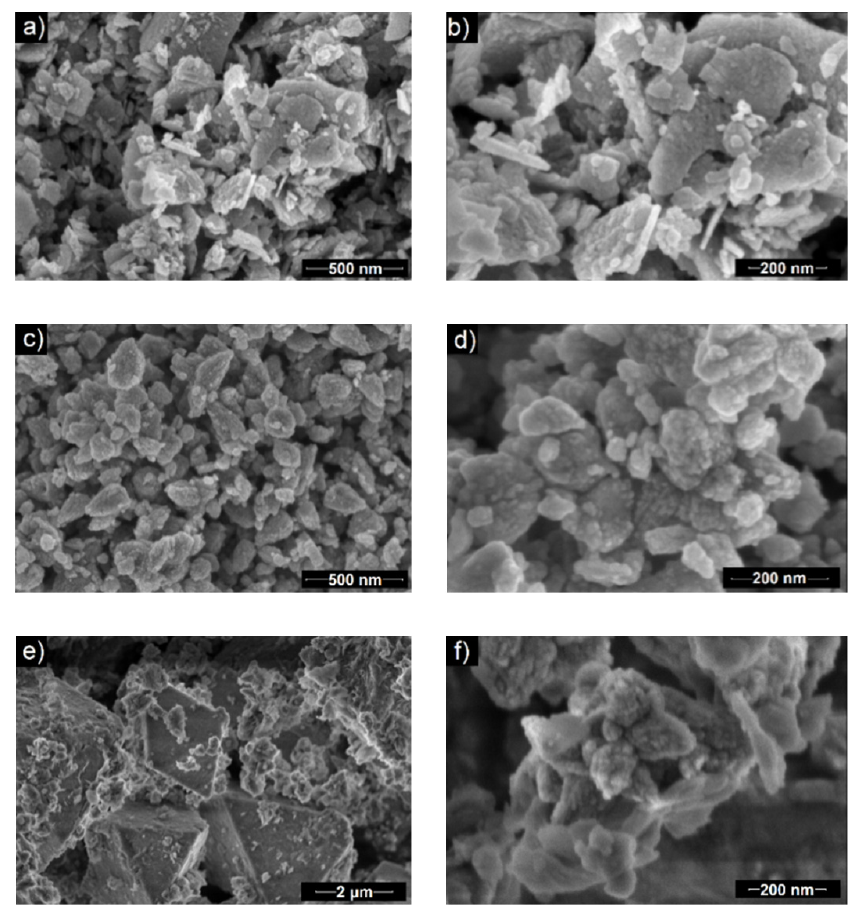
Figure 3. SEM images of the samples: ( a , b ) BT1, ( c , d ) BT2, ( e , f ) BT3. Generally, it could be assumed that by increasing the amount of black tea extract, the particles change their shape and size starting from flat and big particles to more spherical and smaller. Additionally, in the BT3 sample, a fraction of a new material was obtained. Based on previous work by the authors [6], it was supposed that chemical components of the tea extract interact with ZnO crystallites. First, they adsorbed on the wurtzite polar surfaces (0001 and 0001) and suppressed the growth along the c-axis [63]. By increasing the amount of organic compounds, they could start to adsorb on each side of the ZnO hexagonal unit cell, which inhibits its growth in every direction. Because the wülfingite fraction was observed in the BT3 sample, it could be concluded that the black tea extract may influence the process on each of its steps. This was reflected in an altered crystal growth and formation of various phases in the final